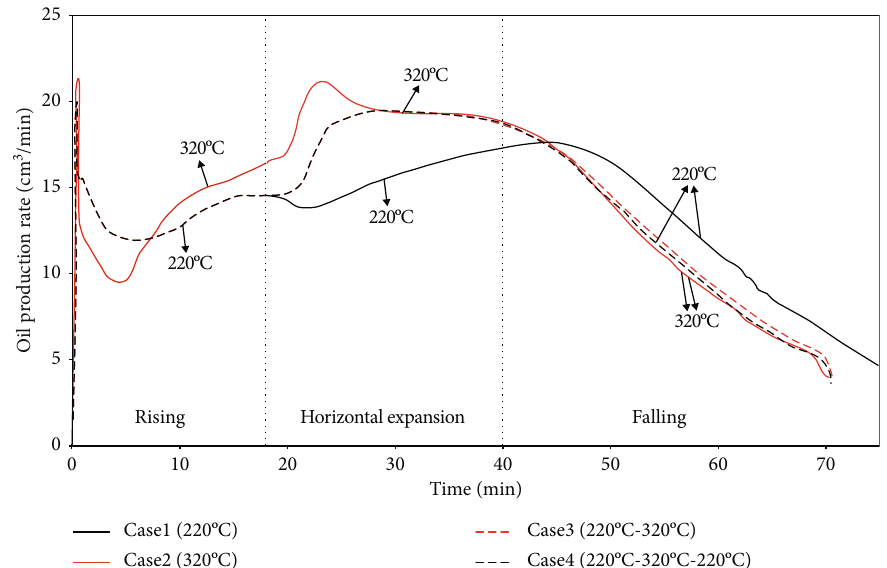
Figure 28: Oil production rate in di ff erent steam injection